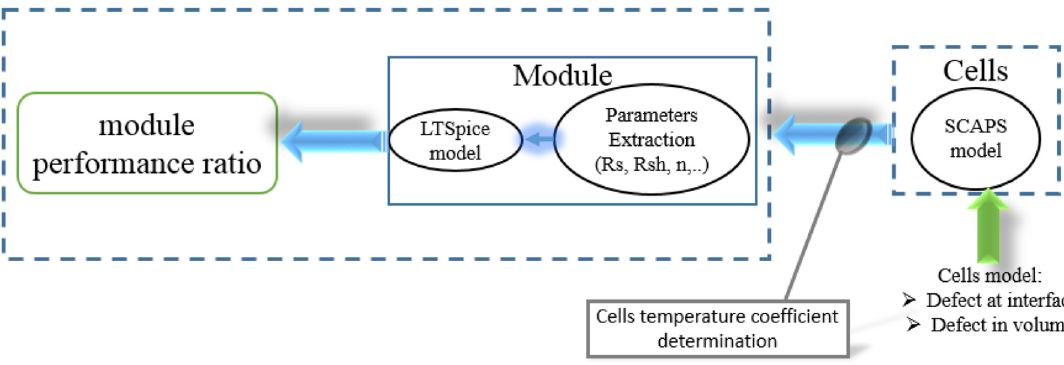
Fig. 1. Summary of the study approach.